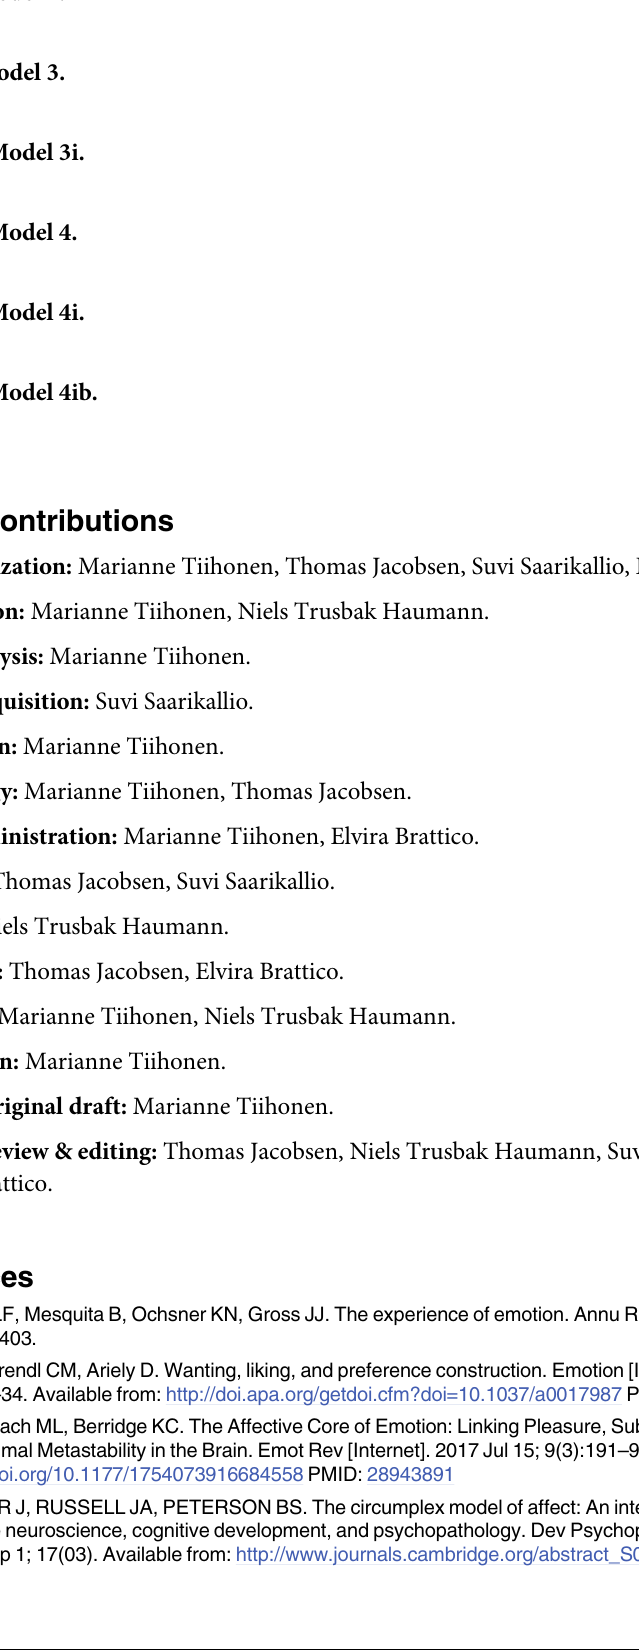
S8 Table. Model 2. S9 Table. Model 3. S10 Table. Model 3i. S11 Table. Model 4. S12 Table. Model 4i. S13 Table. Model